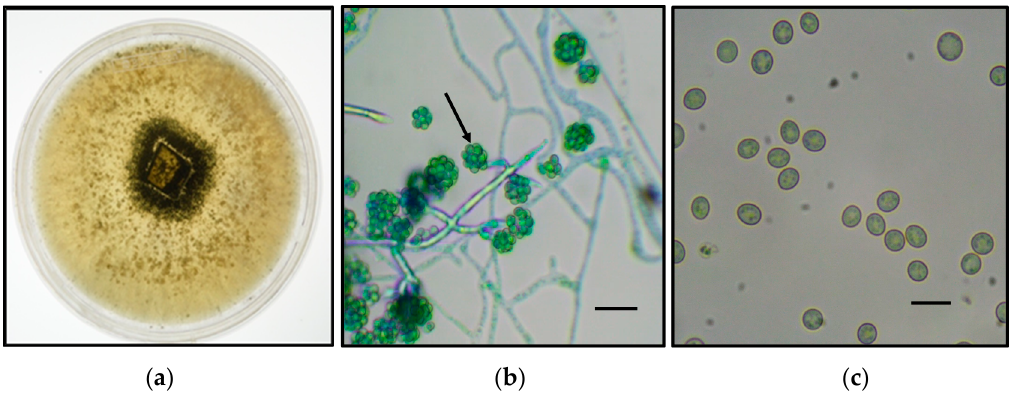
Figure 1. Morphology of strain FG. ( a ) Mycelium from strain FG grown on a potato dextrose agar (PDA) plate for 5 d; ( b ) A sample taken from a mycelium grown on a PDA plate and stained with lactophenol cotton blue. This sample was observed under an optical microscope using 40 × magnification. Bar indicates 20 µ m. Tree-like structures containing conidia can be observed (black arrow); ( c ) Microscopic observation of spores by an optical microscope using 100 × magnification. Bar indicates 5 µ m.